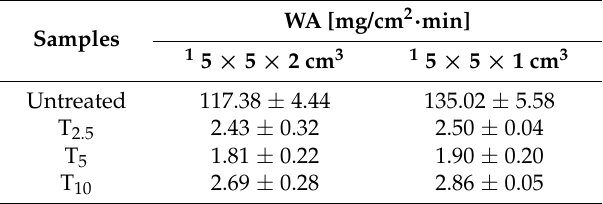
Table 5. Water absorption (WA) measured by the “contact sponge” test. For each data set the maximum deviation is